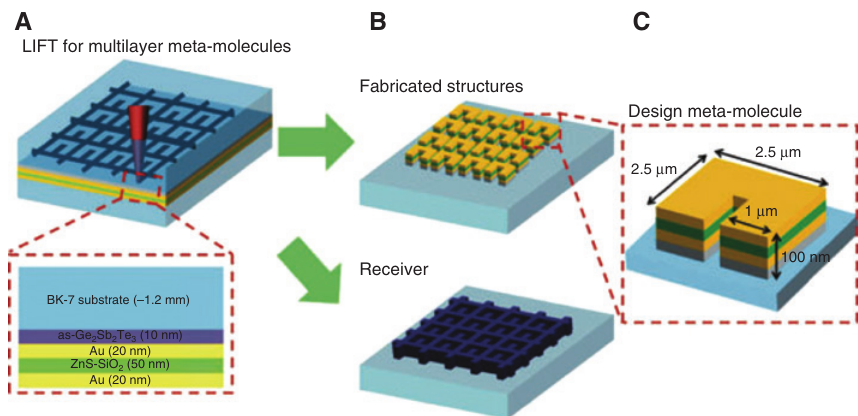
Figure 16: Fabrication of multilayer metamaterials by femtosecond laser-induced forward-transfer technique. (A) Schematics of the fabrication method of the multilayer structures by contact-mode LIFT technique. (B) Separating the laser-processed donor-receiver pair, the fabricated multilayer metamaterials can be obtained. (C) Feature size of design multilayer metamaterial. Reprinted with permission from Ref.